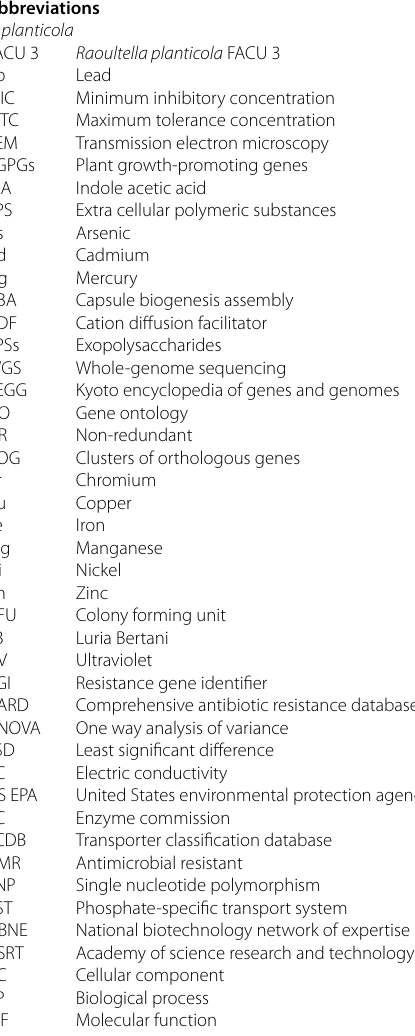
Figure S1. The MIC and MTC. A: for the different three collection locations and B: for the thirty selected lead resistant